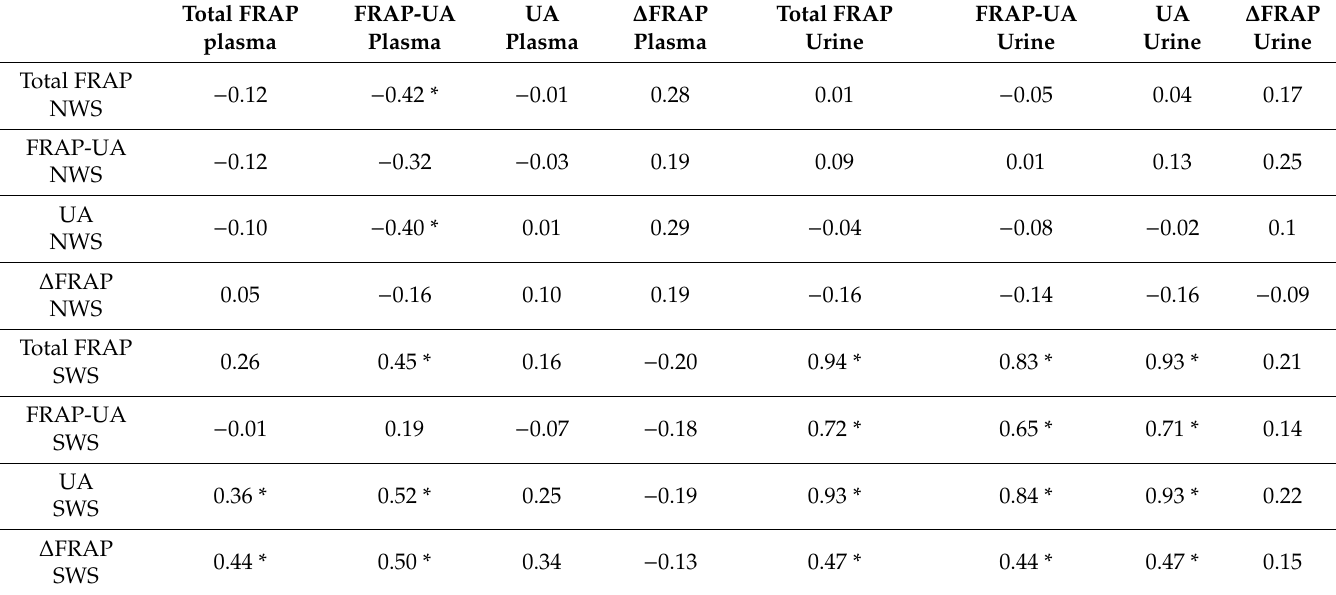
Table 5. Correlations between salivary and plasma / urine total antioxidant capacity measured by FRAP in children with chronic kidney disease (CKD). Total